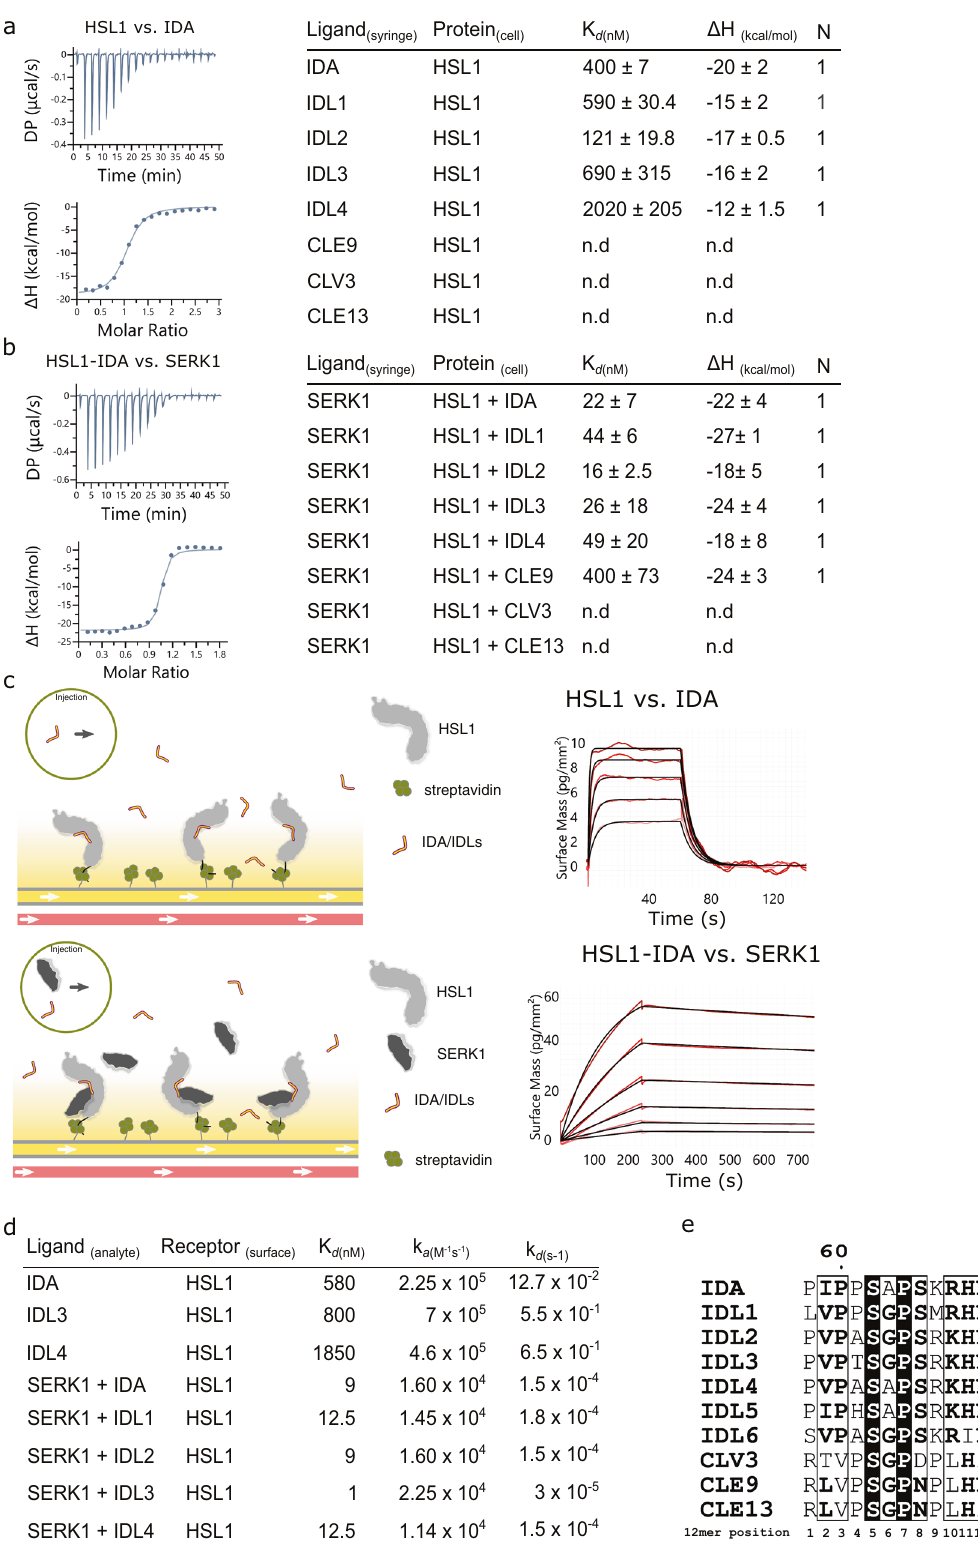
NATURE COMMUNICATIONS| (2022) 13:876